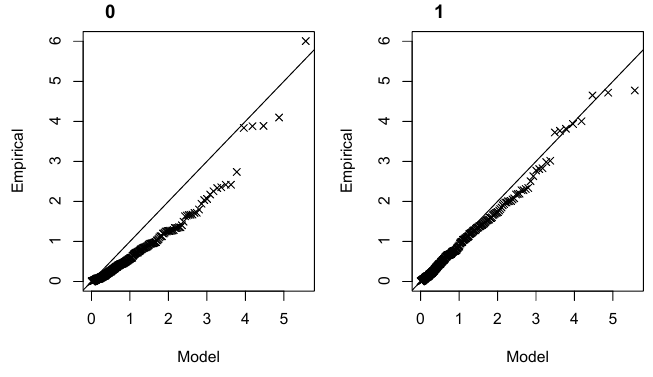
Figure 8. Similar to Figure 7 for H S .